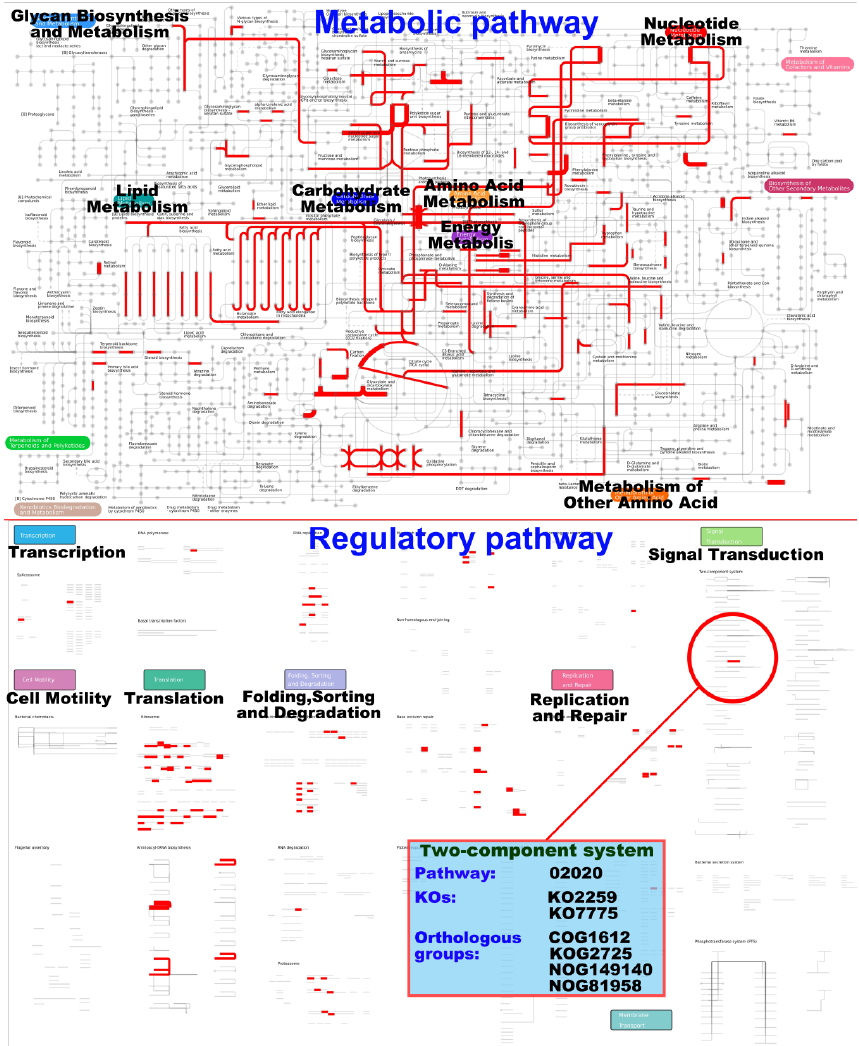
Figure 3. iPath analysis of the differentially expressed genes.